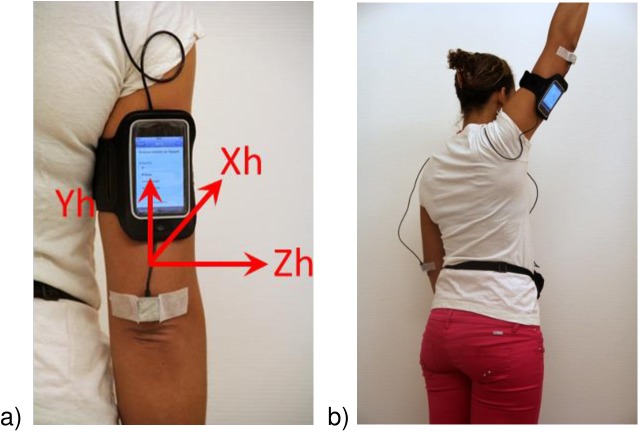
Inertial sensors and smartphone placement and axes.(a) The inertial sensor module (Physilog® reference system) attached to the arm with medical tape and connected by cable to the datalogger carried on wait. The smartphone is attached to the arm with the armband. (b) Test completion of “hand to the ceiling”.